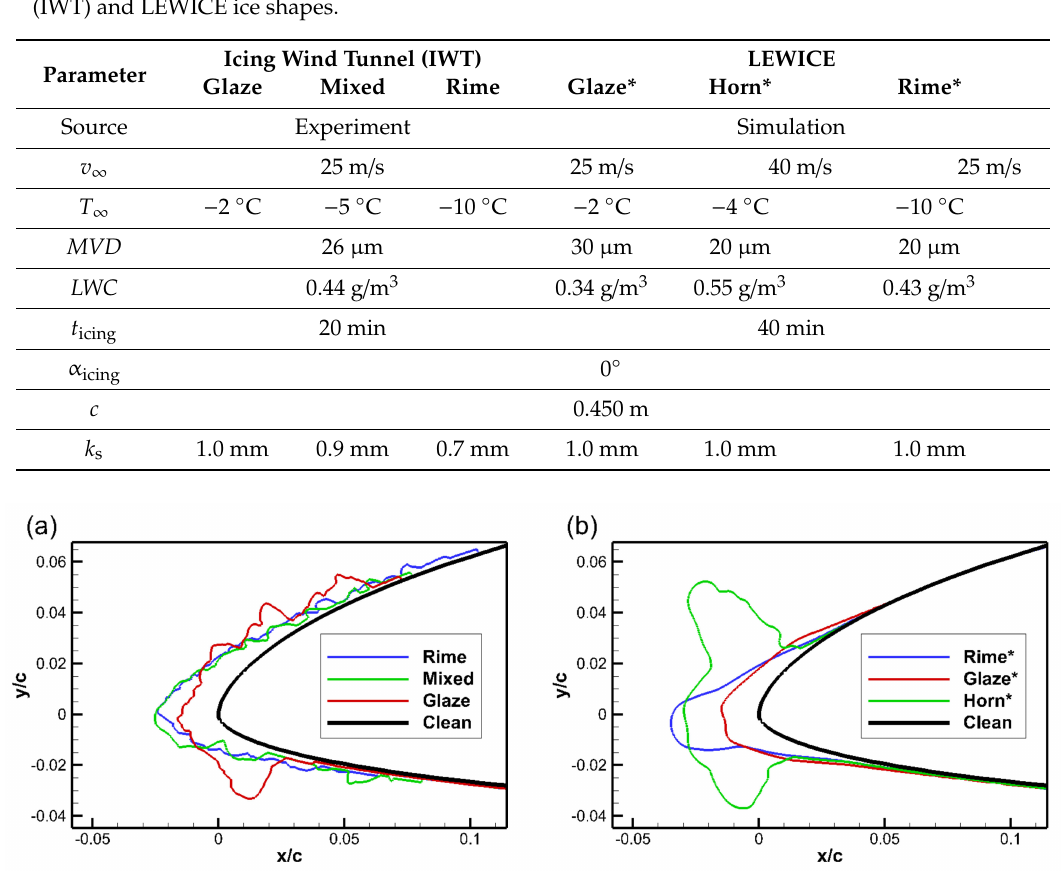
Figure 1. Experimental ice shapes ( a ) and LEWICE ice shapes ( b